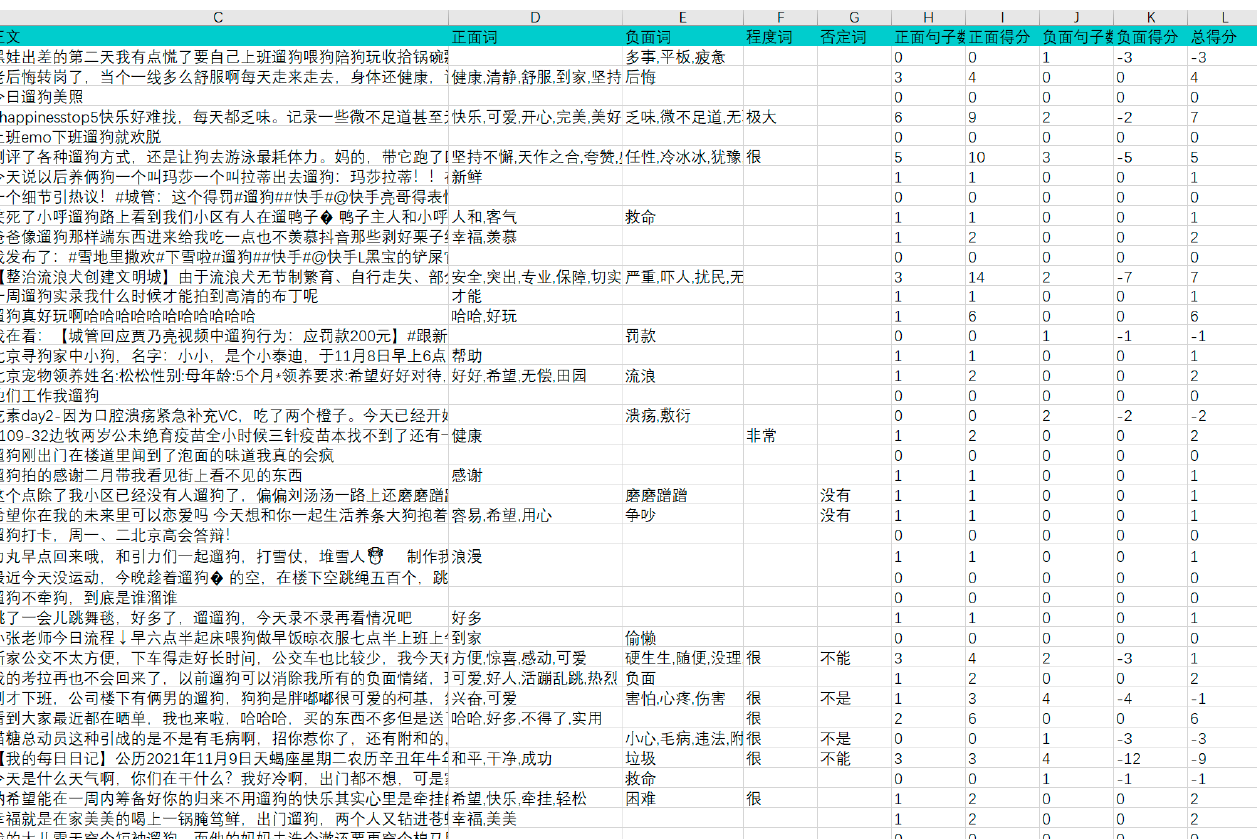
Figure A2. Results of the sentiment analysis based on the Chinese Sentiment Vocabulary Ontology Li- brary.